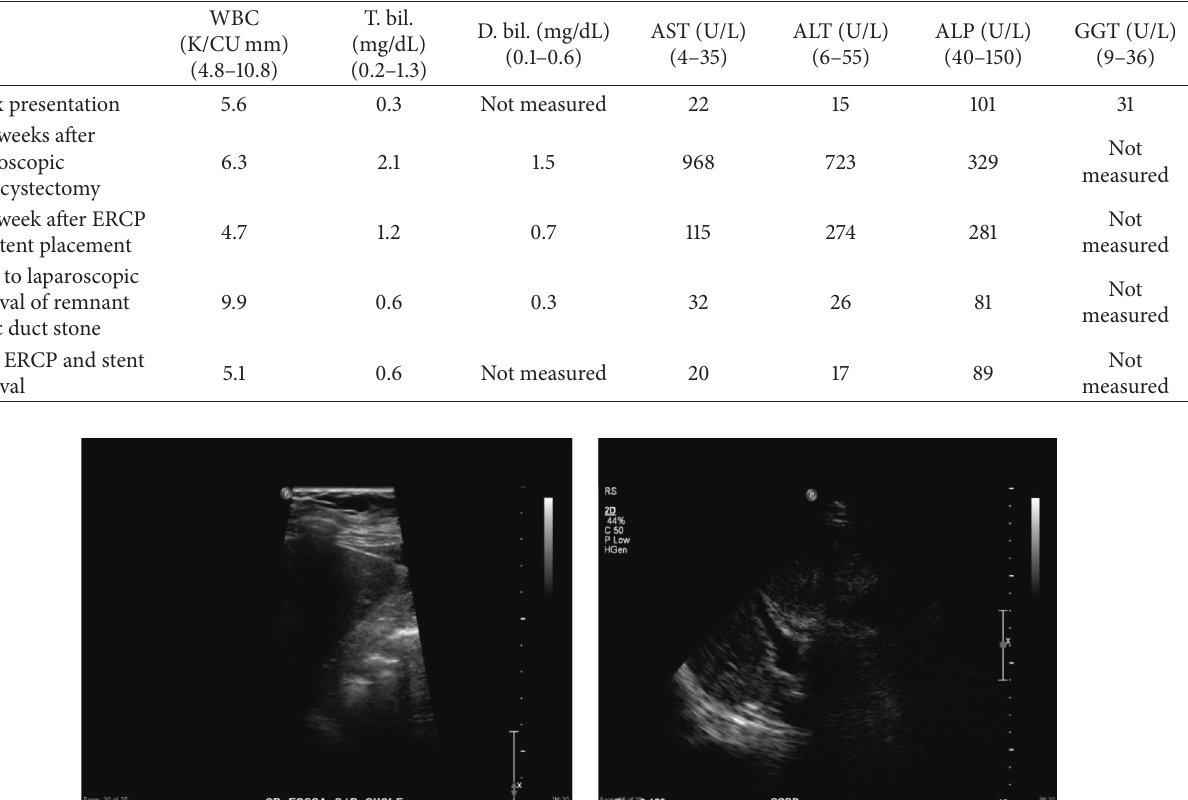
Figure 1: Postoperative abdominal ultrasound showing no evidence of collection and distal common bile duct diameter of 4.6 mm.